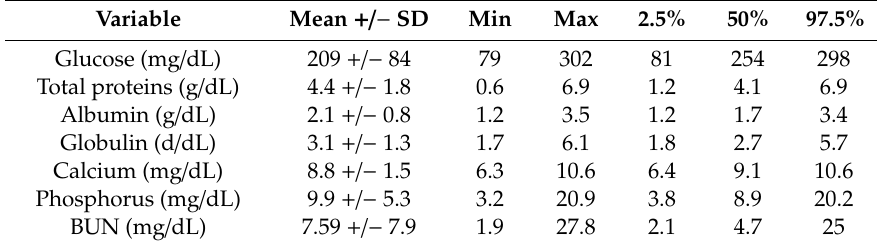
Table 2. Mean ± standard deviation, minimum and maximum values and quartiles and of blood chemistry variables of captive black-faced ibis ( Theristicus melanopis ) (N =